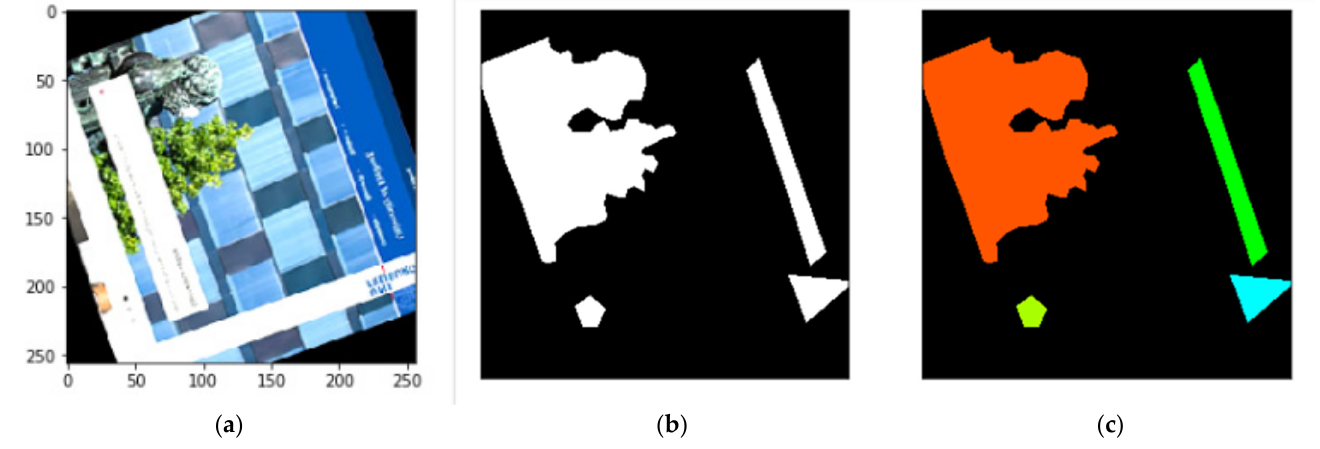
Figure 3. ( a ) Augmented (rotated) image, ( b ) grayscale masked output, and ( c ) label-colored multi- color masked output.